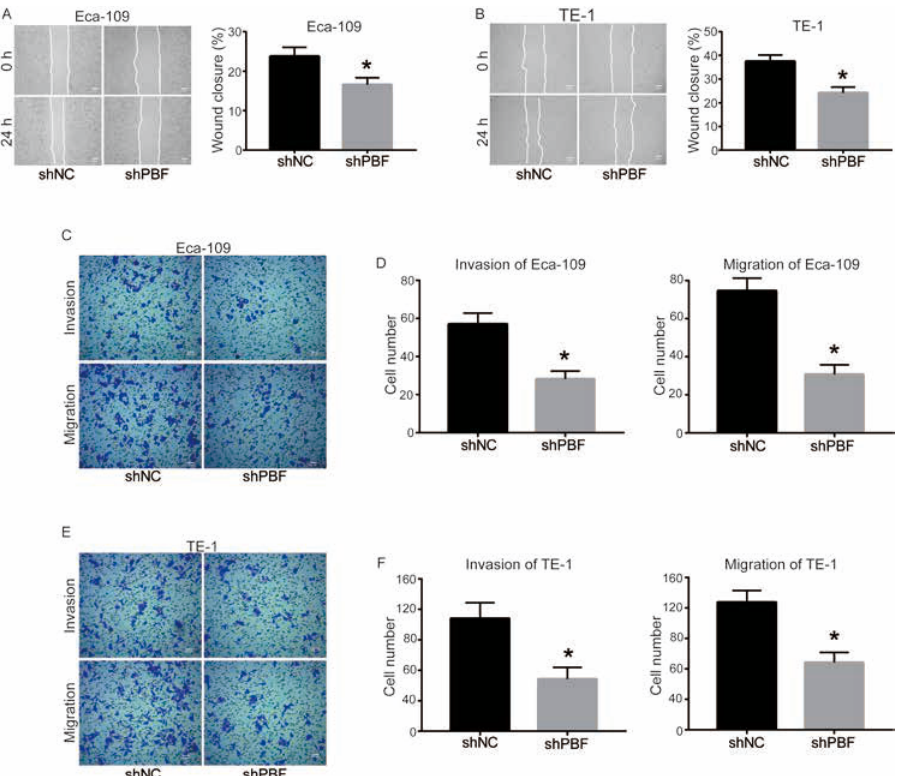
Figure 2: Down-regulation of PBF inhibits cell invasion and migration of ESCA. The ability of wound closure in (A) Eca-109 and (B) TE-1 cells was detected by scratch assay; bar = 1 mm (C) The images of invasive and migrated Eca-109 cells transfected by shNC or sh2-PBF for 48 h; bar = 100 μm. (D) Quantitative results of cell migration and invasion in Eca-109; (E) The image of invasive and migrated TE-1 cells transfected by shNC or sh2-PBF for 48 h; bar = 100 μm. (F) Quantitative results of cell migration and invasion in TE-1. All experiments were repeated 3 times. *P represented significant